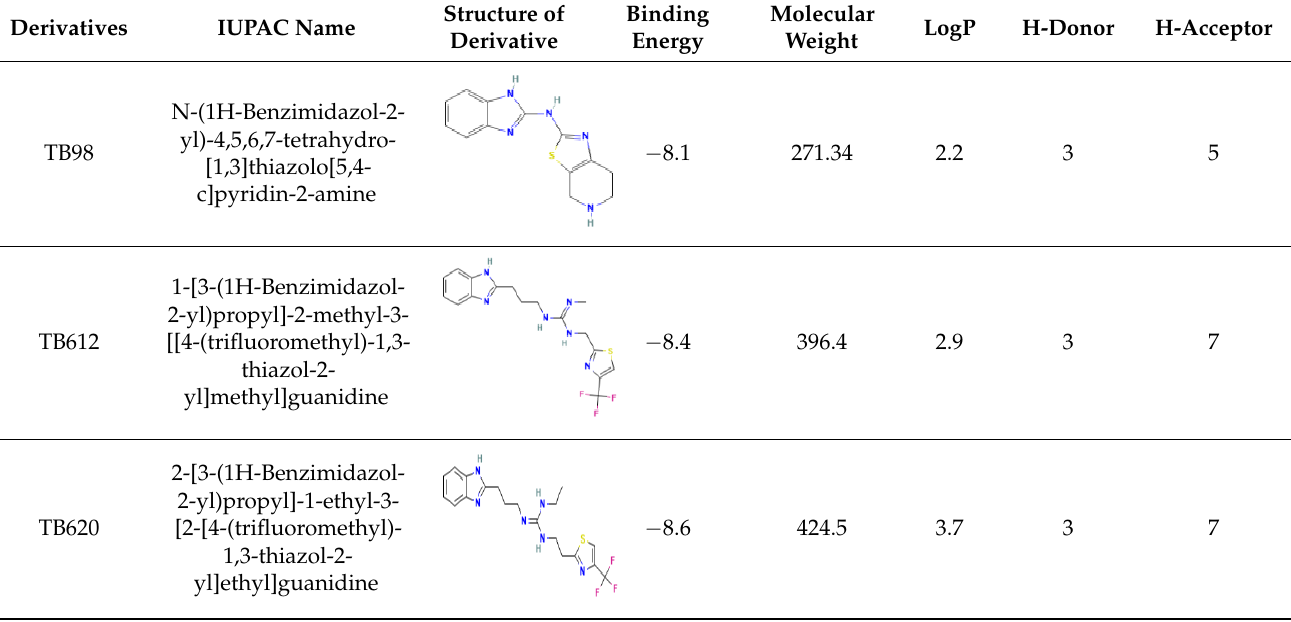
Table 3. Screened Thiabendazole derivatives against ATG8 representing binding energies of ATG8-thiabendazole derivatives, structure and IUPAC names, molecular weight, LogP values, number of Hydrogen donor and acceptors of derivatives.